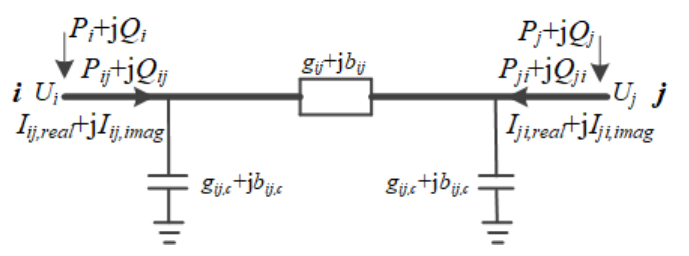
Figure 1. Lumped model of the transmission line.